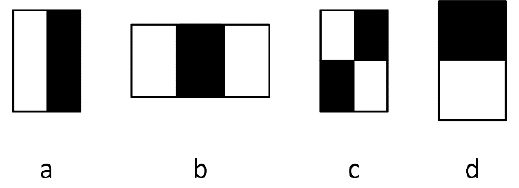
Figure 3. Haar-like features in the Viola and Jones face detection algorithm [41].